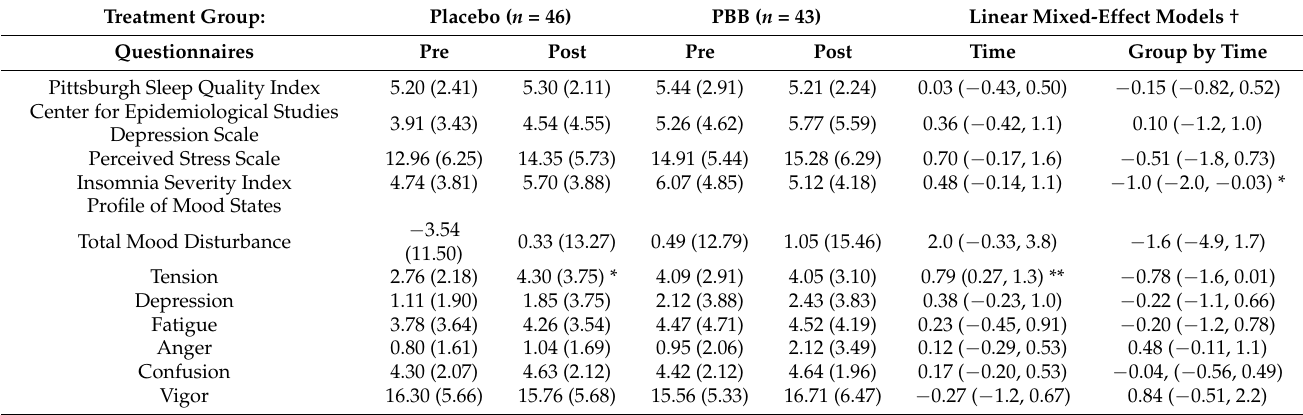
Table 3. Pre–post changes and linear mixed-effects model results for questionnaire outcomes.